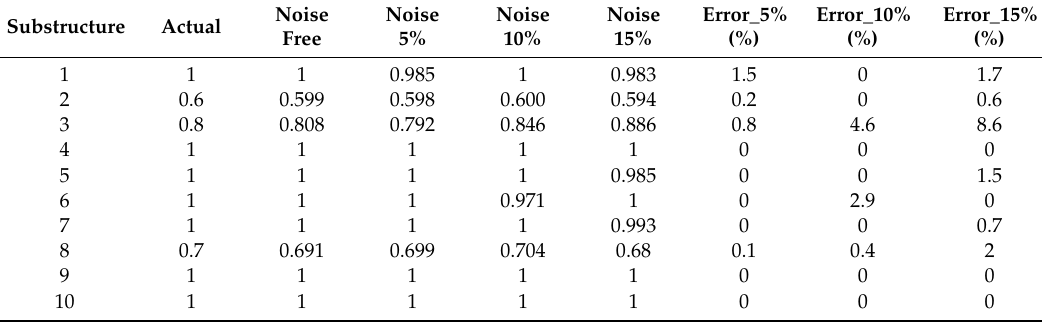
Figure 17. Damage identification results using 1-DOF vehicle model. Table 4. Damage identification results using 1-DOF vehicle model under di ff erent noise Table 3. First four natural frequencies (Hz).